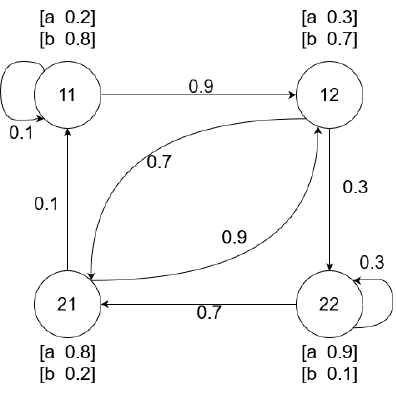
Figure 6. Example of Hidden Markov